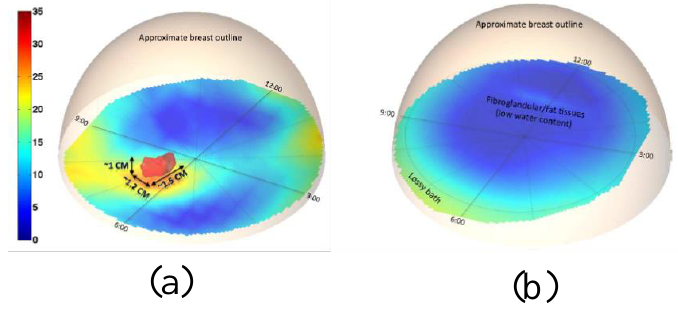
Figure 6. 3D microwave tomographic permittivity images at 1300 MHz obtained from the system developed by Grzegorczyk et al. [67]. ( a ) The 3D structure of a tumour present in the right breast. ( b ) The 3D structure of a tumour-free left breast. Reprinted with permission from